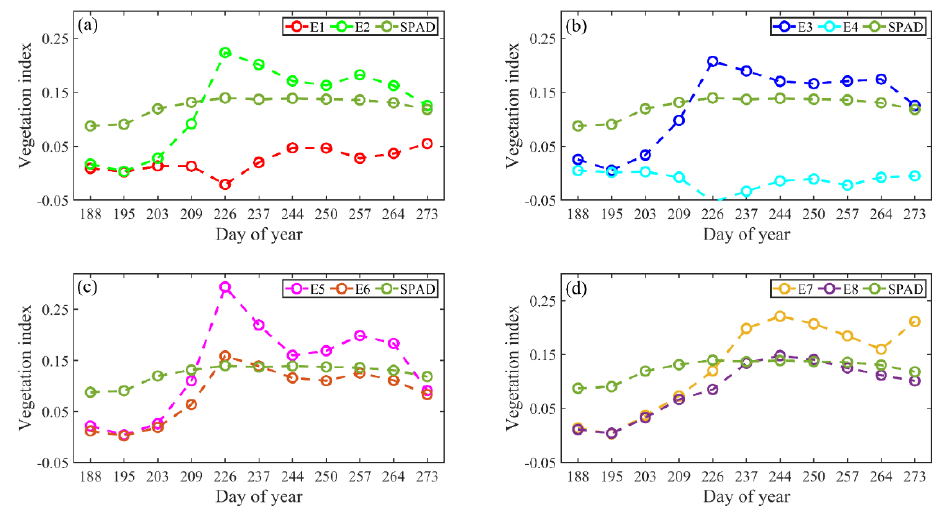
Figure 6. Comparison of VI and normalized SPAD values during the growth of maize. The x-axis indicates the dates of data acquisition in relation to the day of the year. Note: E is short for equation according to Table 2, and E8 is the MRBVI. ( a ) dynamic change of E1, E2 and SPAD; ( b ) dynamic change of E3, E4 and SPAD ( c ) dynamic change of E5, E6 and SPAD and ( d ) dynamic change of E7, E8 and SPAD.